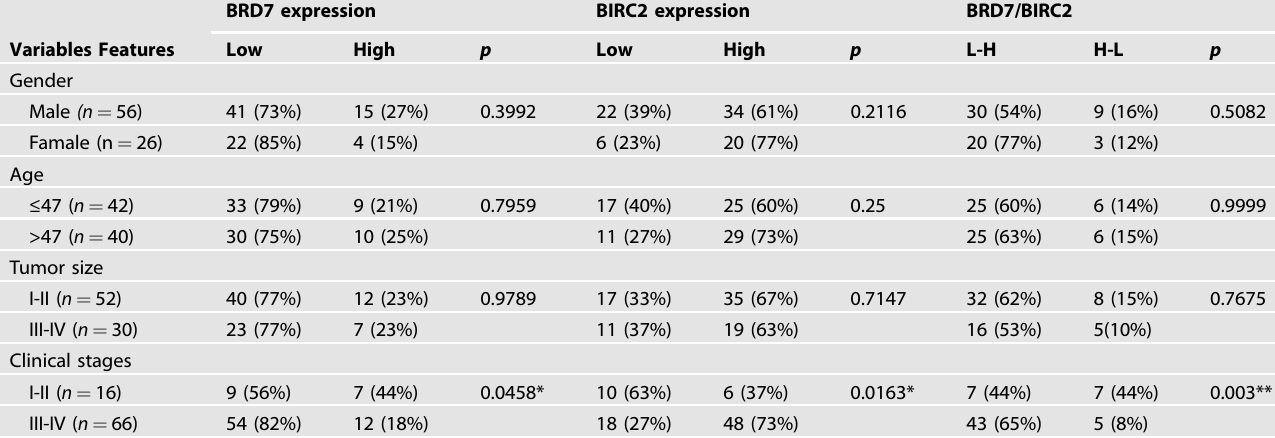
Table 1. Association between the expression of BRD7, BIRC2 and NPC clinical pathological features ( n = 82).